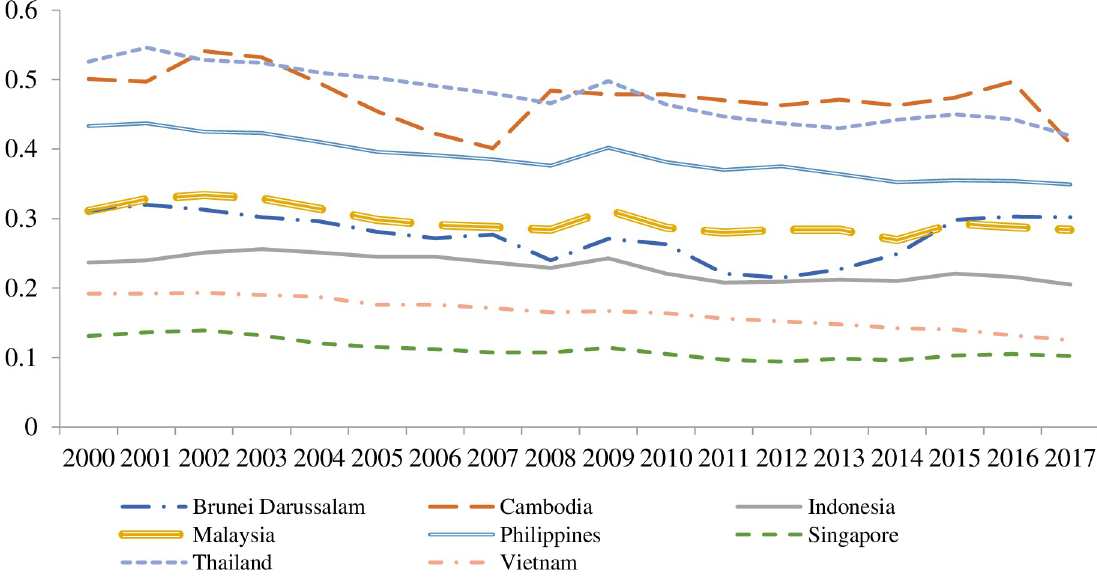
Fig 1. The size of the shadow economy for the ASEAN countries for almost two decades, from 2000 to 2017.